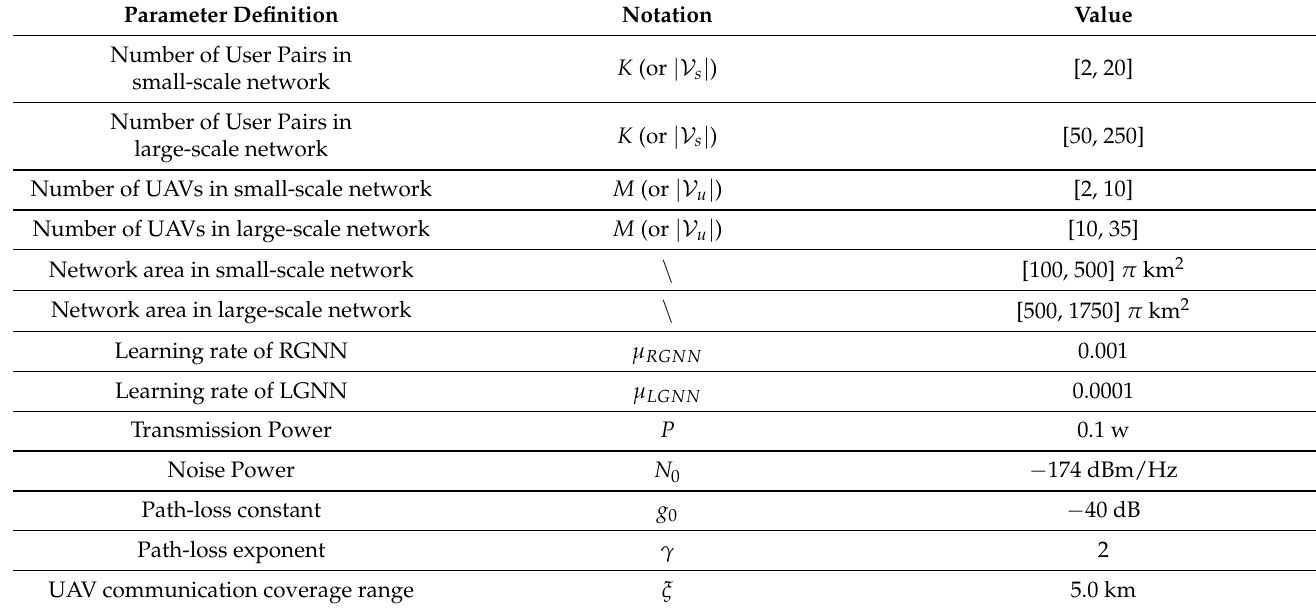
Table 1. Simulation Parameters in the training